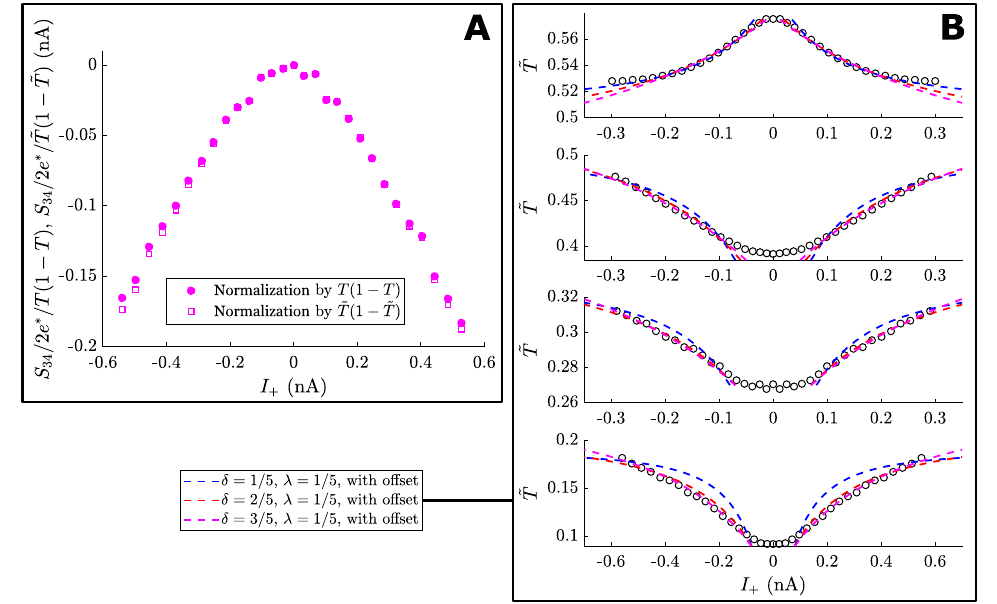
˜ T ð I Þ on the inner channel of ν ¼ 2 = 5 . (a) Comparison between S þ